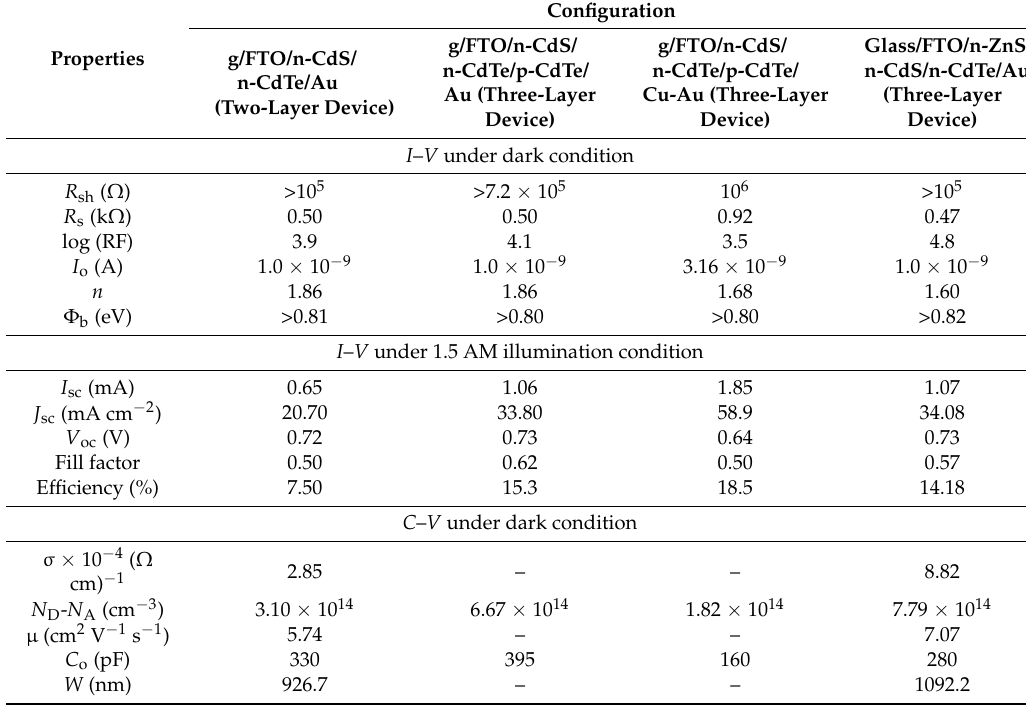
Table 3. Summary of device parameters obtained from I – V (both under illuminated and dark conditions) and C – V (dark condition) for glass/FTO/n-CdS/n-CdTe/Au and glass/FTO/n-ZnS/n-CdS/n-CdTe/Au solar